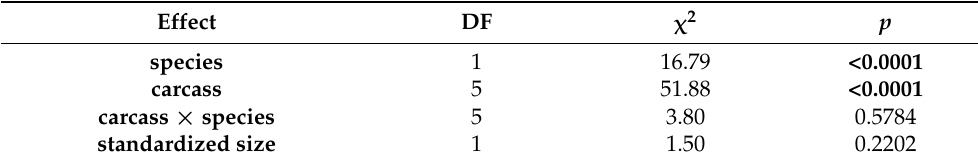
Table 3. Results of ANCOVA for number of reproductive bouts. Significant effects are bolded.